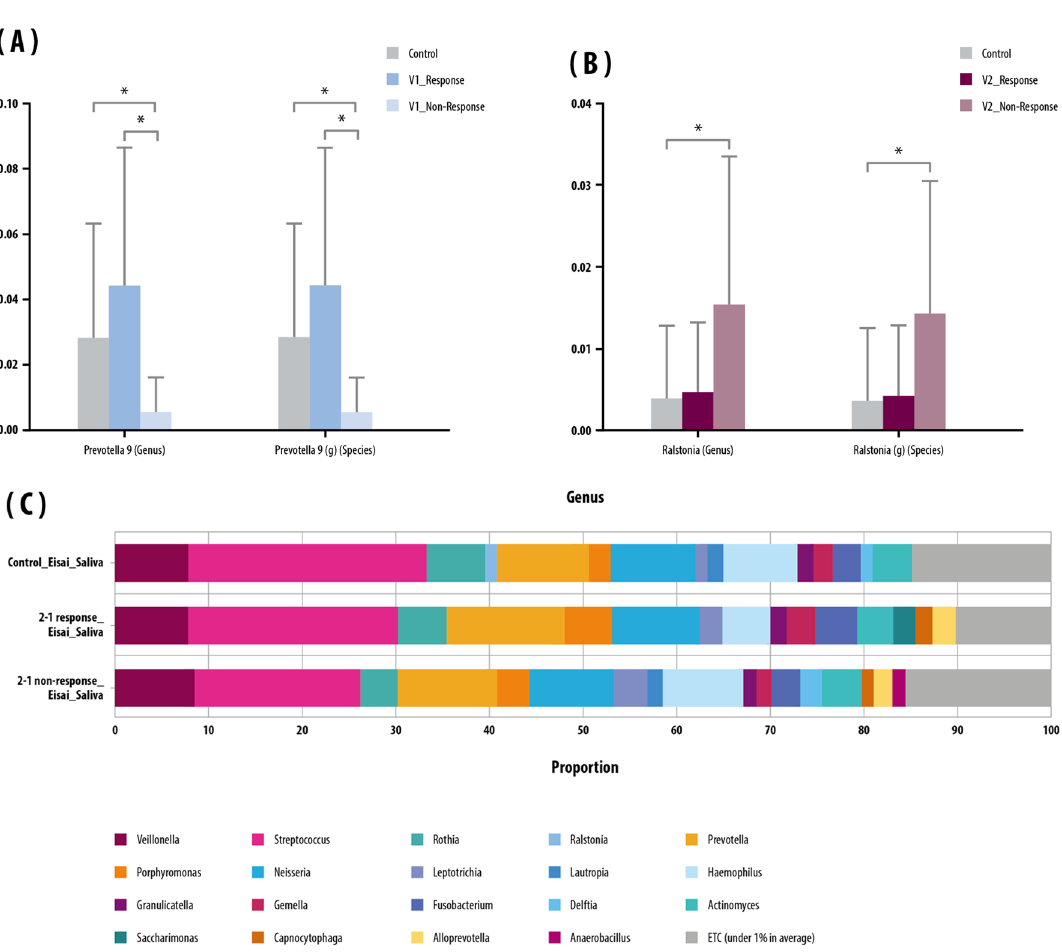
Figure 3. Saliva: microbial composition in the saliva of the control and inflammatory bowel disease (IBD) groups classified by clinical response/non-response. ( A ) Proportion of genera using 16S rRNA. ( B ) Mean relative abundance of genera and species abundant before anti-TNF-α treatment (V1). ( C ) Mean relative abundance of genera and species abundant after anti-TNF-α treatment (V2). Kruskal–Wallis and Wilcoxon tests were used. Bars above columns indicate standard deviation. * p <